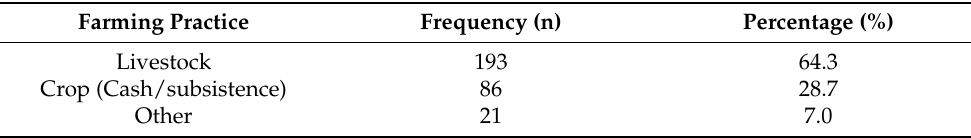
Table 3. The different types of additional farming practices.